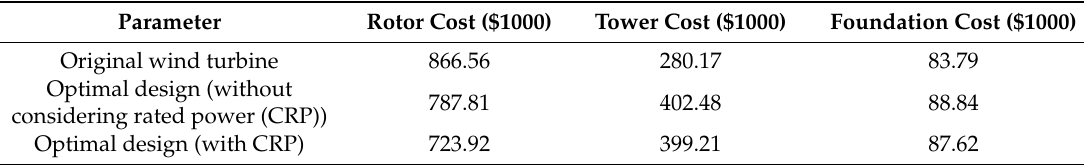
Table 7. Costs of rotor, tower, and